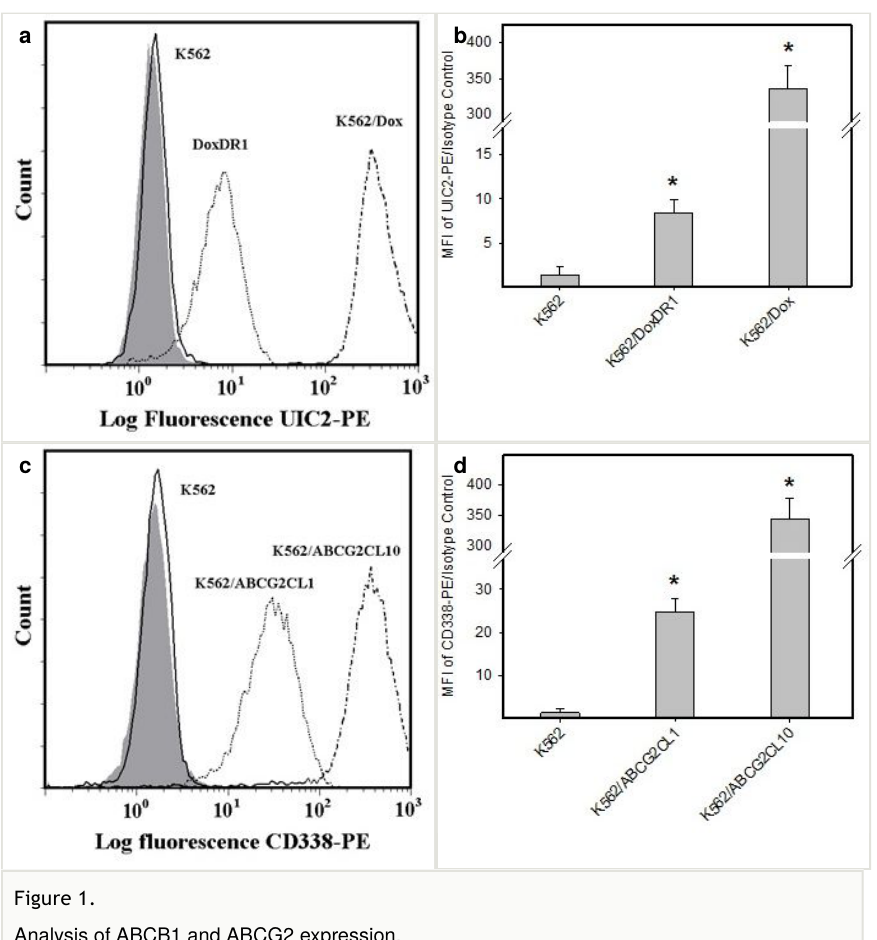
Figure 1. Analysis of ABCB1 and ABCG2